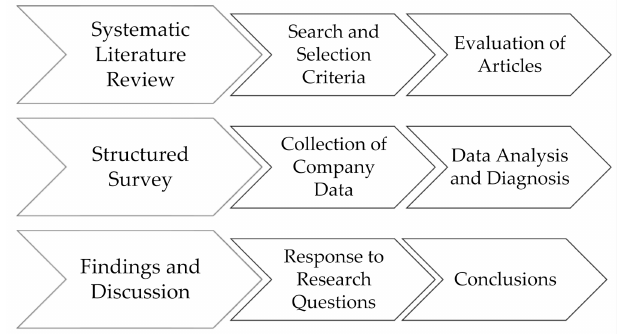
Figure 1. Outline of the study